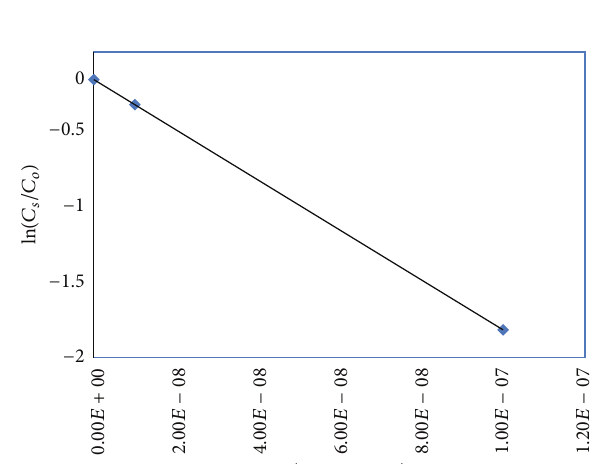
Figure 2: Variation of ln (𝐶 𝑠 /𝐶 𝑜 ) as a function of time for a constant rate constant.